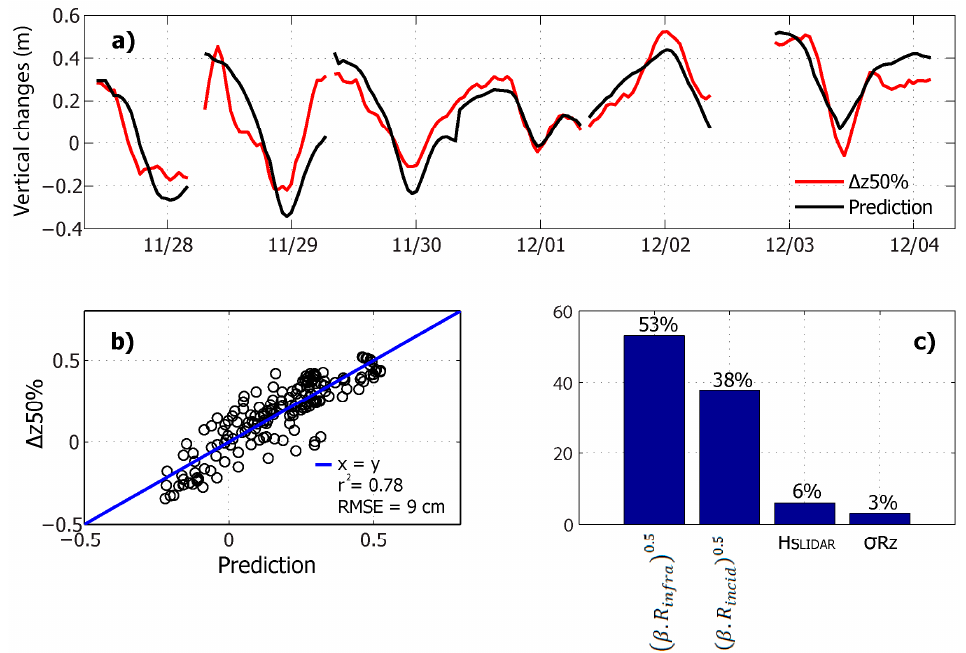
Figure 10. ( a ) Predictions of the multiple linear regression model (black line) compared with the cumulative vertical changes in the mid swash zone ( Δ z50%, red line) observed during the field experiment. ( b ) Scatter diagram showing the correlation between the multiple linear regression model and Δ z50% observations. The coefficient of correlation (r 2 ) obtained for this linear regression was 0.78. ( c ) Individual contributions of the forcing parameters used in the multiple linear regression expressed as a percentage.